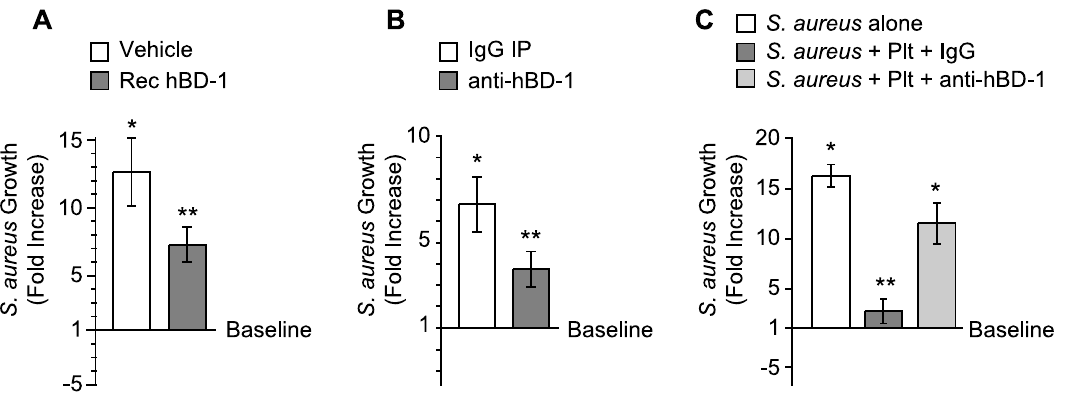
Figure 4. Platelet-derived b -defensin 1 inhibits the growth of S.aureus . (A) S. aureus growth was determined in the presence of recombinant hBD-1 (400 ng/ml) or its vehicle. The bars represent the mean 6 SEM of the fold increase in S. aureus growth (240 minutes) over baseline (horizontal line). The single asterisk indicates a significant increase (p , 0.05) in growth over baseline. The double asterisks indicates a significant (p , 0.05) reduction in S. aureus growth in the presence of recombinant hBD-1 when compared to S. aureus incubated with its vehicle. (B) S. aureus growth in the presence of immunoprecipitates that were captured from platelet lysates incubated with anti-hBD-1 or its control IgG. The bars represent the mean 6 SEM of the fold increase in S. aureus growth (240 minutes) over baseline (horizontal line). The single asterisk indicates a significant increase (p , 0.05) in the growth of S. aureus that was treated with IgG immunoprecipitates over baseline. The double asterisks indicates a significant (p , 0.05) reduction in S. aureus growth in the presence of anti-hBD-1 immunoprecipitates when compared to IgG immunoprecipitates. (C) The growth of S. aureus in the absence or presence of platelets that were co-incubated with a neutralizing antibody against hBD-1 or its IgG control. The bars represent the mean 6 SEM of the fold increase in S. aureus growth (240 minutes) over baseline (horizontal line). The single asterisk indicates a significant increase (p , 0.05) in the growth of S. aureus alone or S. aureus co-incubated with platelets and anti-hBD-1 over baseline. The double asterisks indicates a significant (p , 0.05) reduction in S. aureus growth in the presence of platelets incubated with control IgG when compared to S. aureus alone or S. aureus co-incubated with platelets and anti-hBD-1.